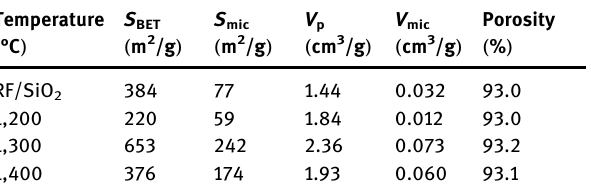
Table 1: Pore structure data of C/SiO 2 aerogel at di ff erent temperatures